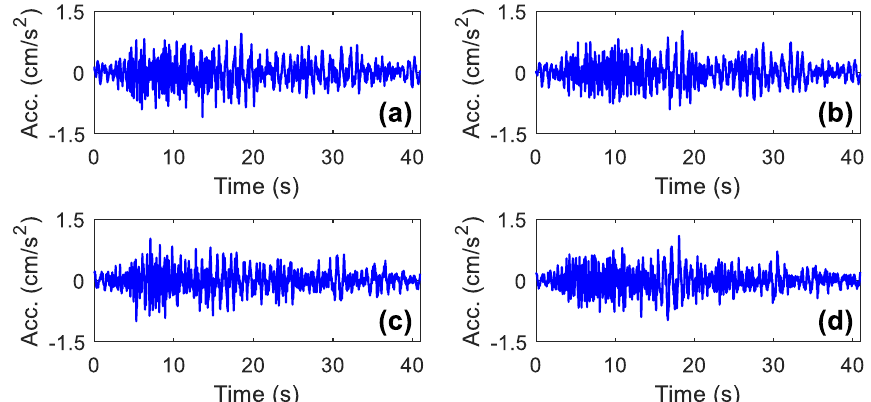
Fig. 12 Simulated earthquake time histories at a site 1, b site 2, c site 5, and d site 6 of the Jiuzhou bridge